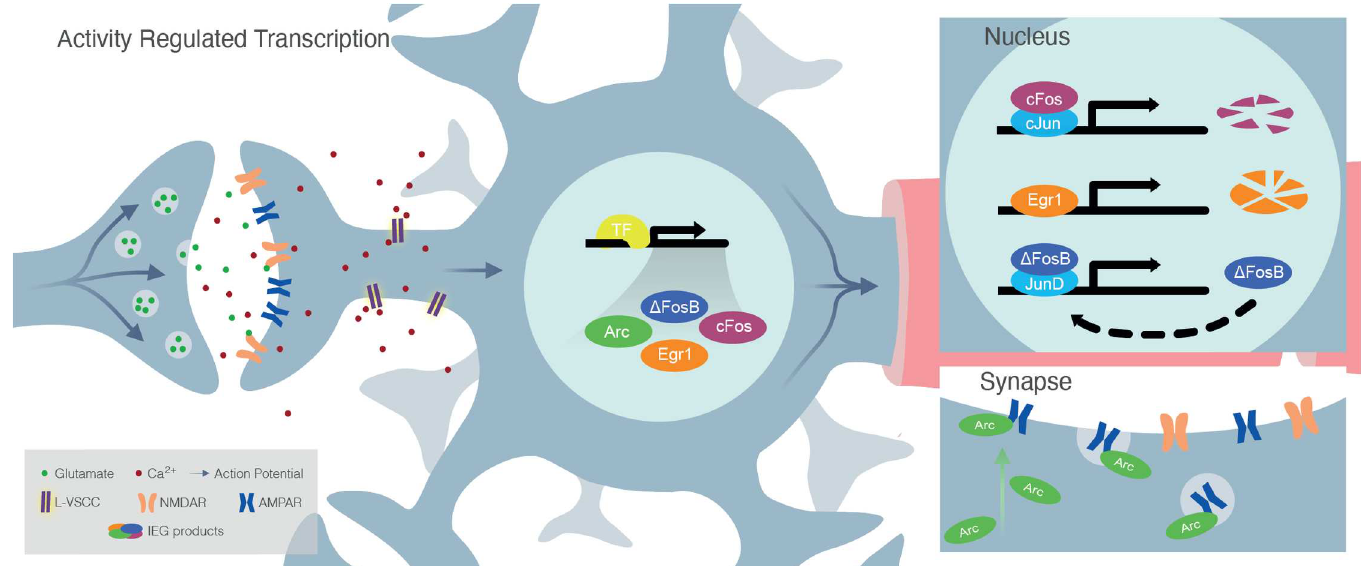
Fig 1. Mechanisms of IEG activation. A) Action potentials induced by glutamate signaling result in membrane depolarization, which in turn results in opening of L-type voltage calcium channels (LVCCs). The resulting Ca 2+ influx induces calcium-dependent signaling pathways. These cascades further result in the recruitment of existing transcription factor, such as CREB, which in turn lead to the expression of IEGs. Once transcribed, IEGs act as B) transcription factors in the nucleus or C) regulators of synaptic plasticity at the synapse as, for example, post-synaptic proteins. B) The transcription factors of the Fos family bind to a transcription factor of the Jun family to form the AP1 complex, whereas Egr1 acts independently. Egr1 and cFos are transiently expressed, whereas Δ FosB accumulates over time in the nucleus. C) Arc acts at the post-synaptic density by reducing the number of surface AMPA receptors. Therefore, increased Arc expression results in reduced synaptic strength by AMPA receptor